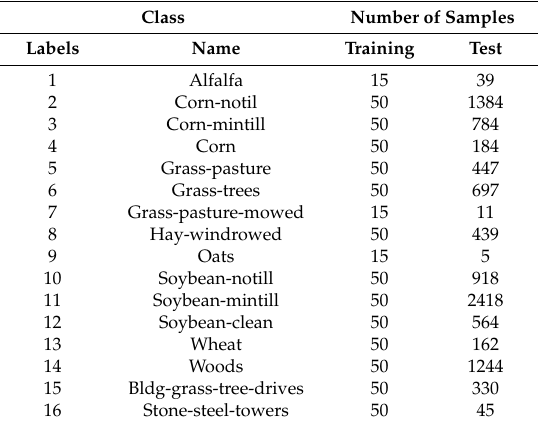
Table 2. Indian Pines dataset: number of training and test